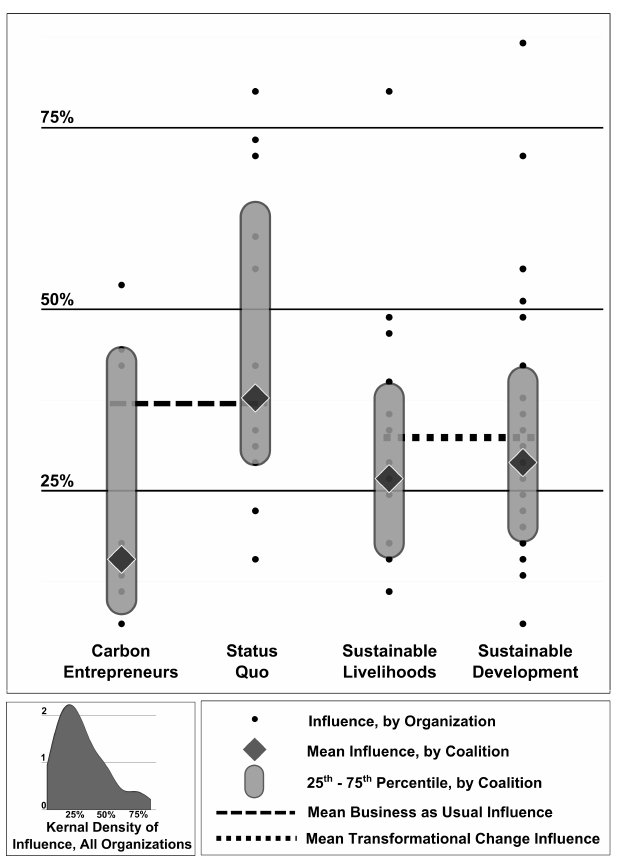
Fig. 1 . Perceived influence of REDD+ advocacy coalitions in Papua New